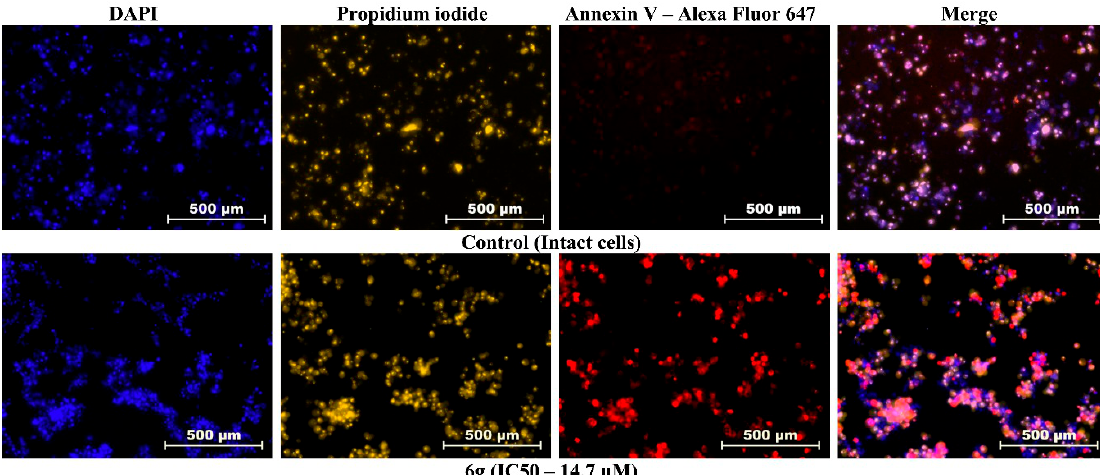
Figure 3. Images of control intact M-Hela cells ( top ) and M-Hela cells after treatment with 6g at an IC 50 concentration of 14.7 µM ( bottom ), obtained using the Cytell Cell Imaging multifunctional system using the BioApp Automated Imaging application. Annexin V-Alexa Fluor 647 (red fluorescence) was used to detect apoptotic cells; living cells—DAPI (blue fluorescence); dead cells—propidium iodide (yellow fluorescence).